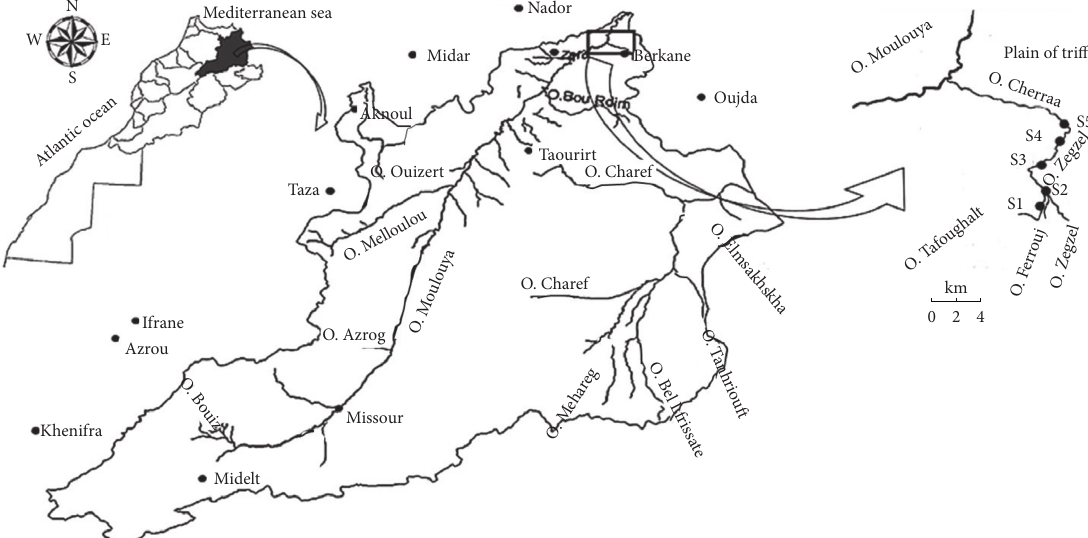
Figure 1: Localization of the study area, Zegzel watercourse, Morocco.